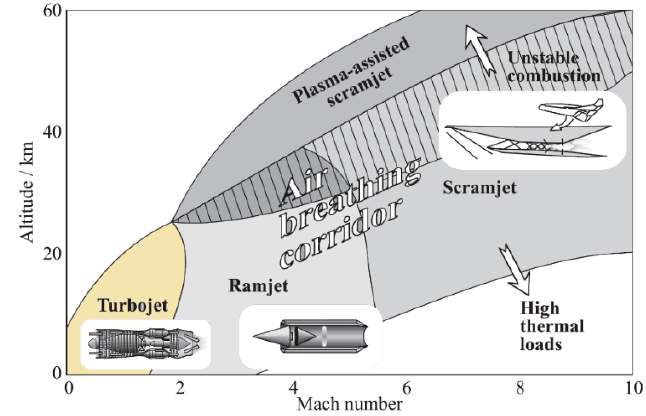
Figure 1. Qualitative diagram of air breathing corridor with assumed range of altitude and velocity where PAC might be the most effective [2]. Energies 2018 , 11 , x FOR PEER REVIEW